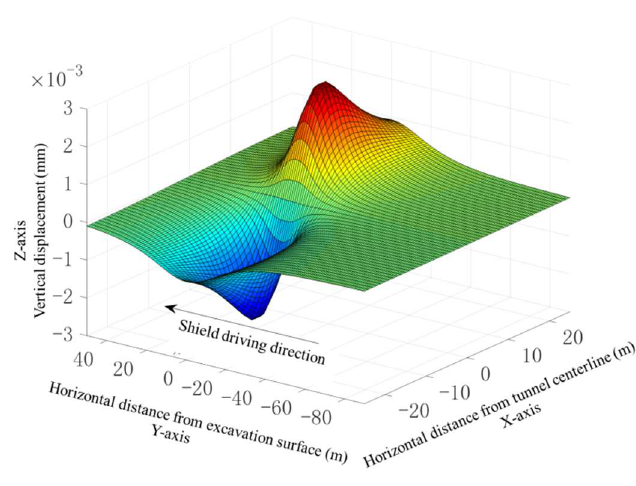
Figure 12. Ground movements induced by cutter head rotation.